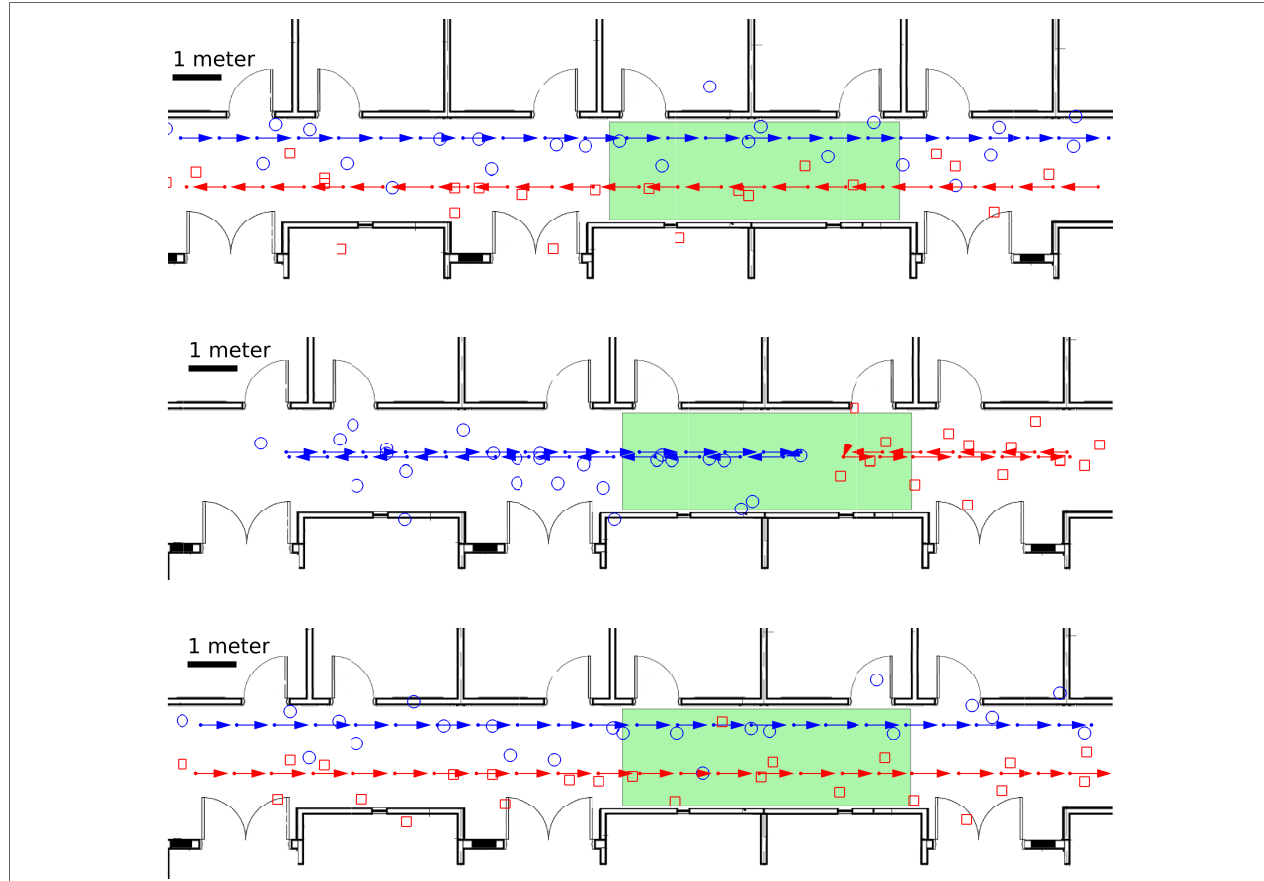
FIGURE 7 | From top to bottom the diagrams show the crossing scenario, the pivot scenario and the together scenario. Each diagram has blue arrows → for the ground truth of movement for each step of person #1 and red arrows → for person #2. The blue circles ◦ and red squares (cid:3) show examples of the estimated footstep locations produced by the localization algorithm in Poston et al. (2017) for person #1 and #2, respectively. The highlighted green area is the region of interest.